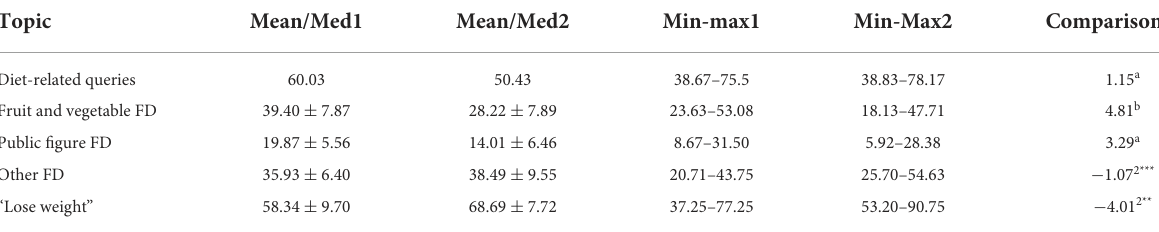
TABLE 3 The comparison of die and lose weight search behavior before and during the COVID-19 pandemic in Indonesia. Topic Comparison